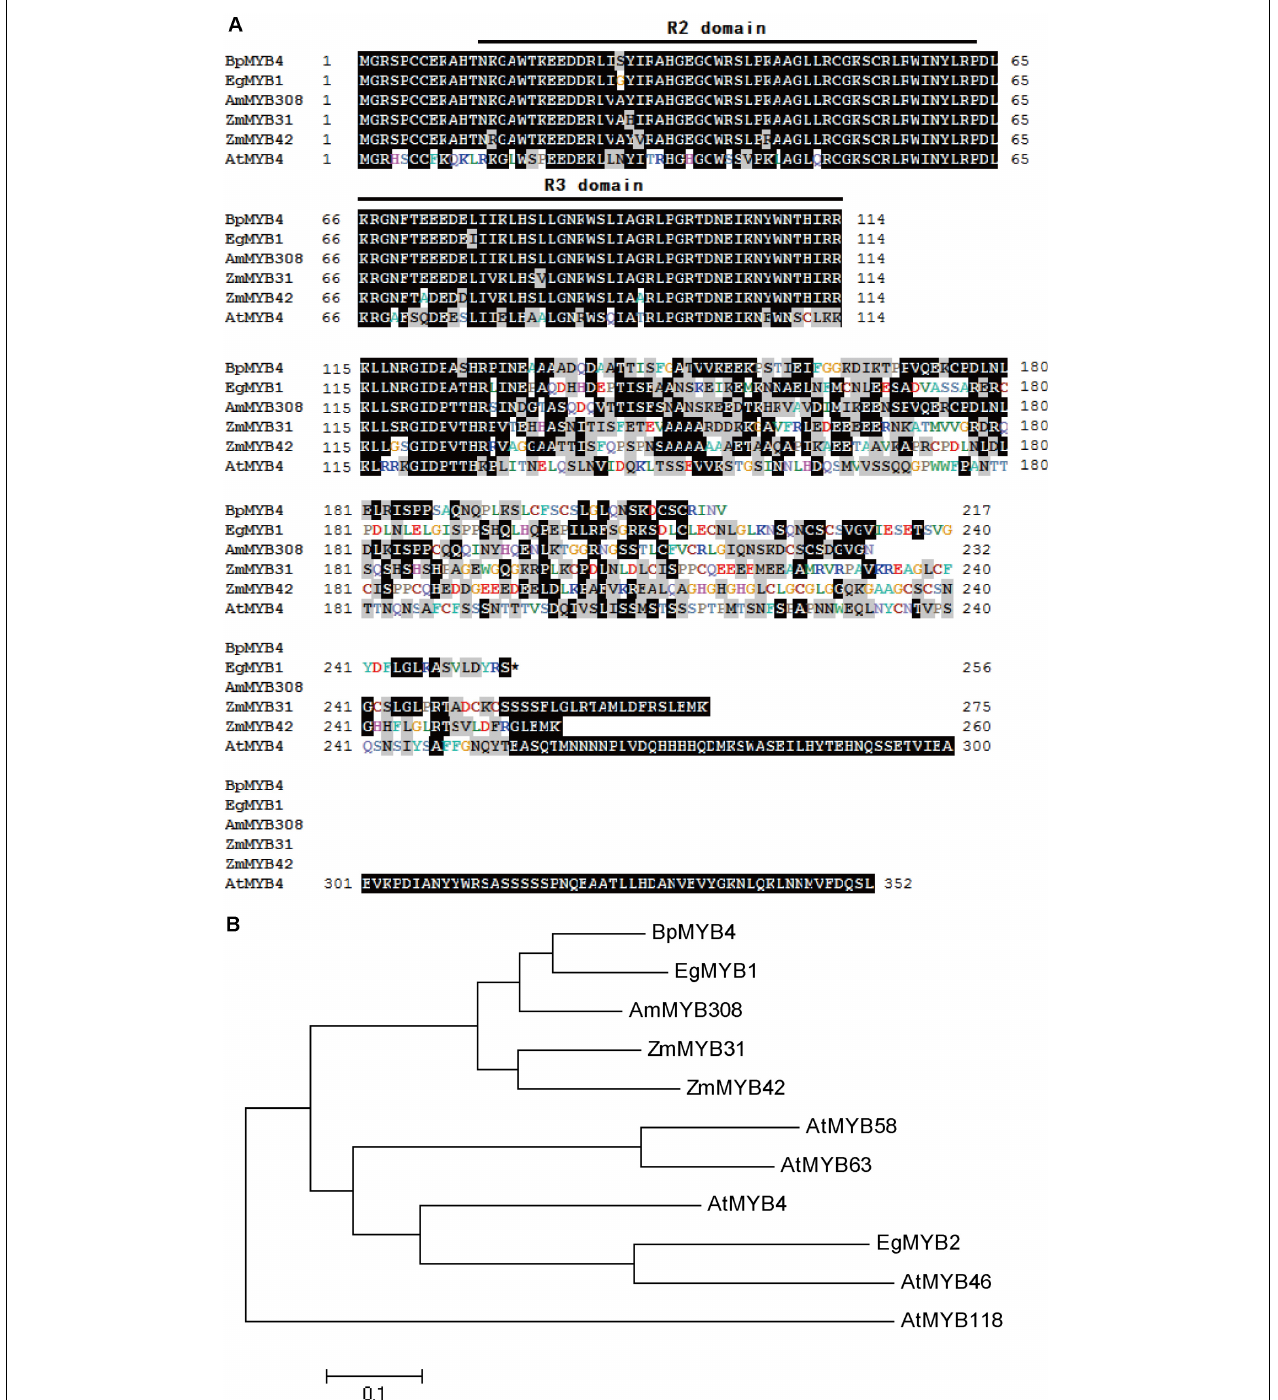
FIGURE 1 | Sequence analysis of BpMYB4. (A) ClustalW alignment of EgMYB1 and homologous proteins using BioEdit. Black and gray shadings represent identical and similar amino acids, respectively. The conserved regions R2 and R3 MYB DNA binding domains are indicated at the top. (B) Neighbor joining tree of BpMYB4 and homologous proteins (Bootstrap = 1000). Full-length amino acid sequences were used to construct the tree with the Mega 5.0 software. GenBank accession numbers: EgMYB1 (CAE09058), EgMYB2 (AJ576023), ZmMYB31 (CAJ42202), ZmMYB42 (CAJ42204), AmMYB308 (P81393), AtMYB4 (AF062860), AtMYB46 (NM121290), AtMYB58 (AF062893), AtMYB63 (AF062898), AtMYB118 (AF334817).